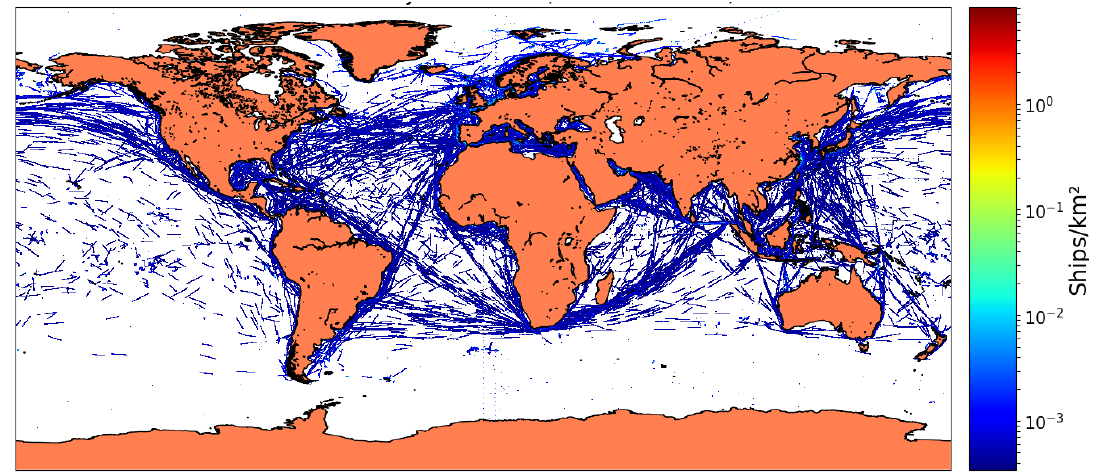
Figure 7. Average maritime traffic density based on an interpolated AIS dataset for one day.